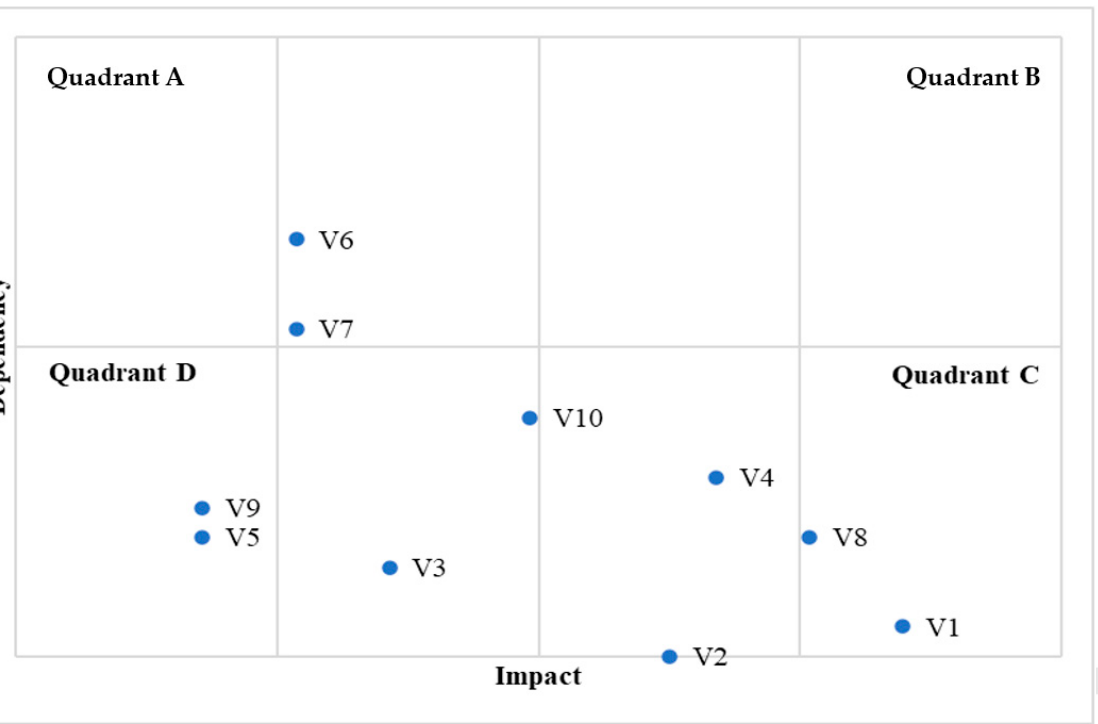
Figure 1. Selection of relevant variables.